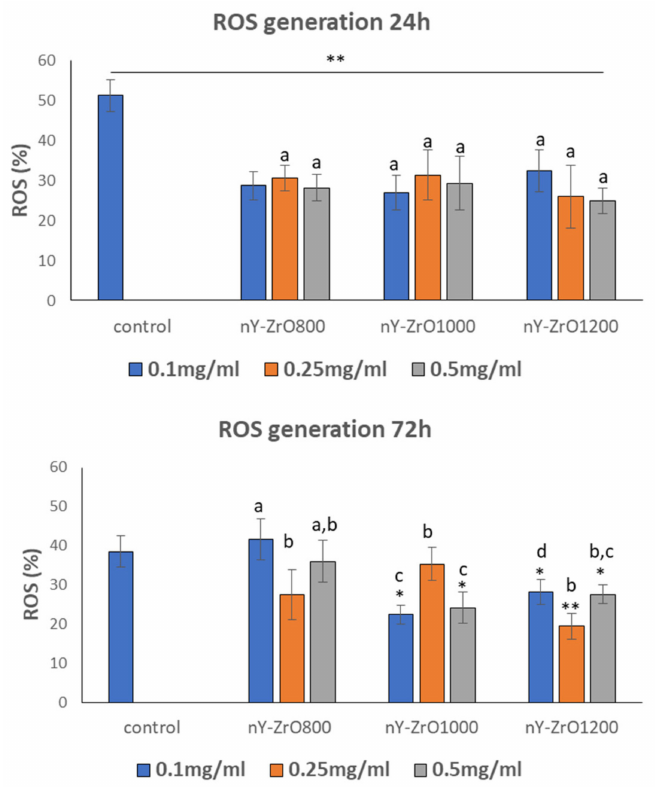
Figure 6. Reactive oxygen species (ROS) measured using H2DCFDA in HGF cells treated for 24 and 72 h at different concentrations (0.1, 0.25, 0.5 mg/mL) of yttria-stabilized zirconia nanofillers. * Indicates statistically significant difference ( p < 0.05) between treated and untreated cells without nanoparticles (control), ** indicates statistically significant difference ( p < 0.0001) between treated and untreated cells without nanoparticles, while different letters suggest statistically significant differences ( p < 0.001) among